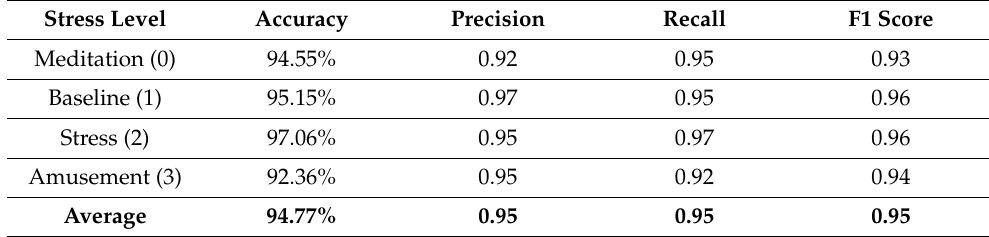
Figure 7. Graph showing the plot of the loss function with several epochs in the x ‐ axis and its cor ‐ responding losses in the y ‐ axis.